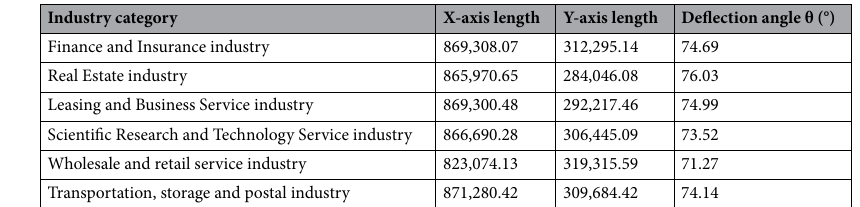
Table 3. Standard deviation ellipse parameters for each industry in the producer